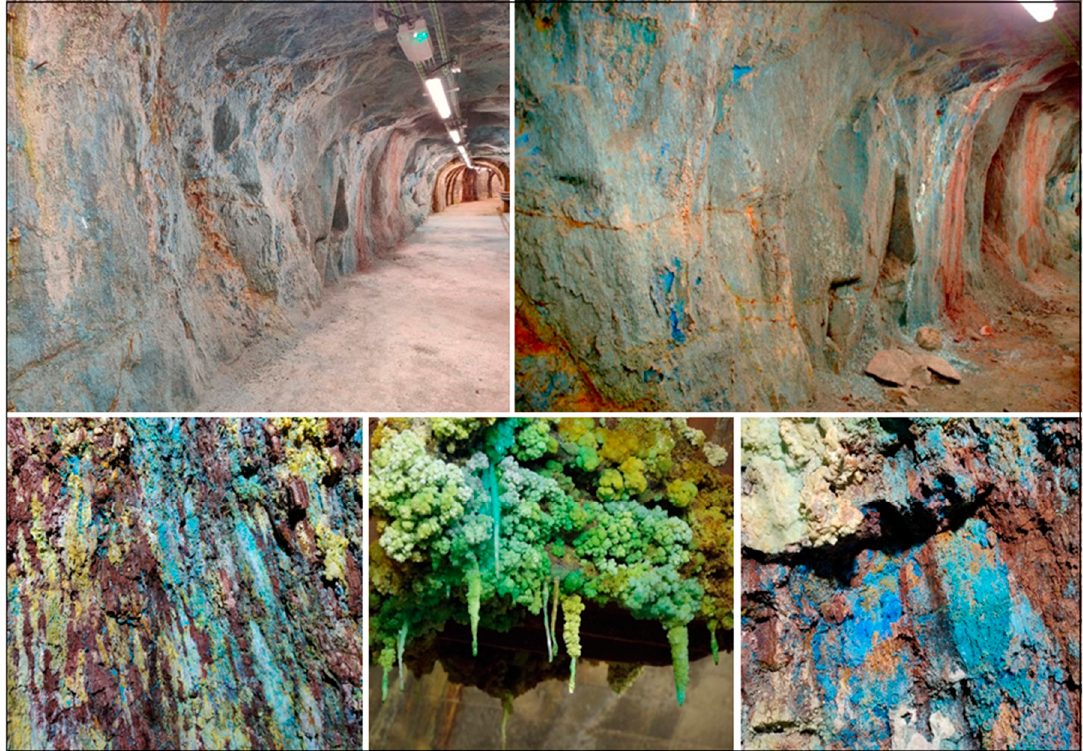
Figure 2. Aspects of the coloured walls in the Algares +30 level adit (the blue is mainly chalcanthite), and green stalactites (melanterite) observed below the Algares ore storage silo.